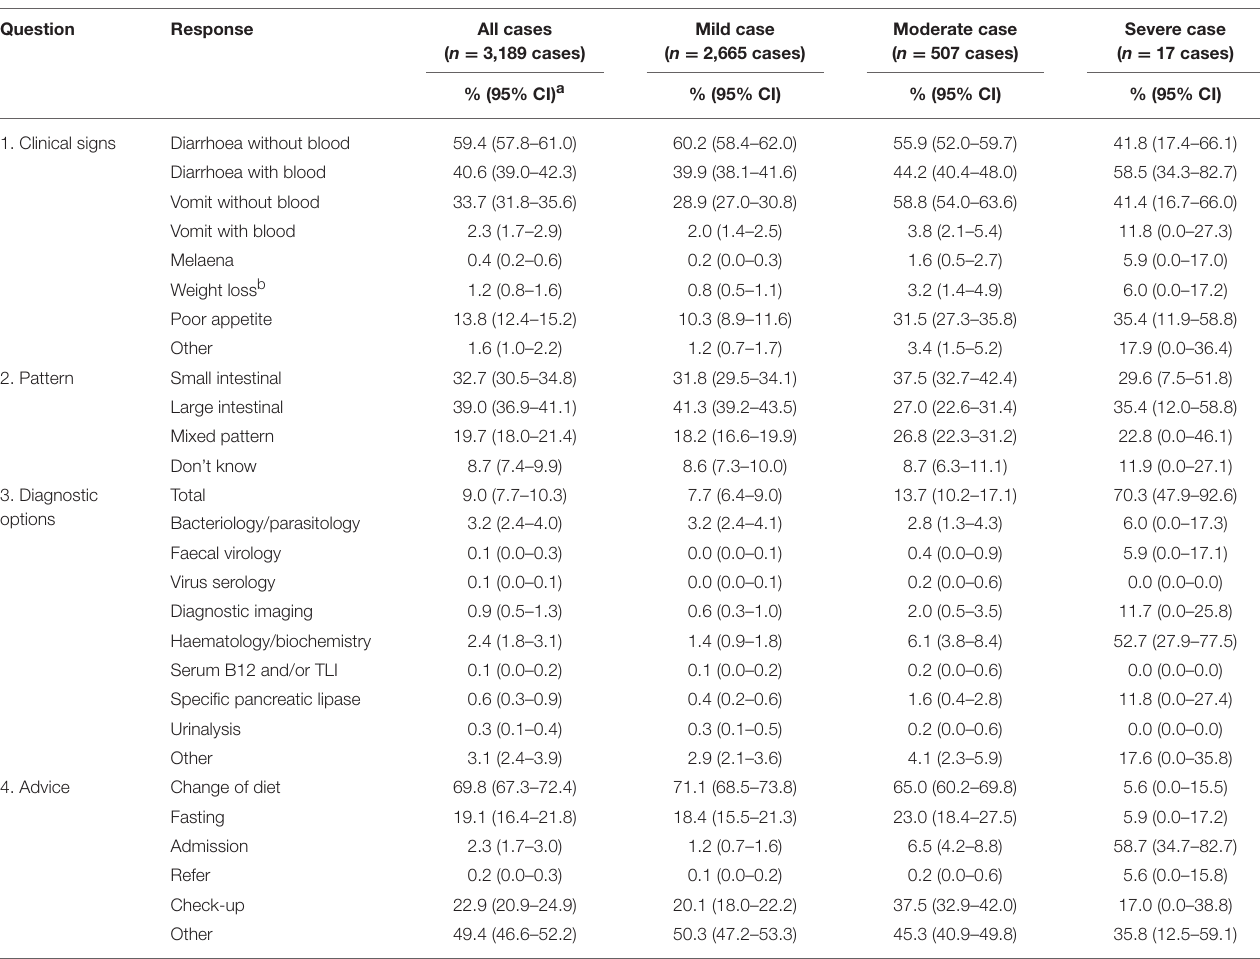
TABLE 2 | Descriptive summary of questionnaire responses for both the entire study population and when stratified by the consulting veterinary professional’s assessed case severity, according to questionnaire